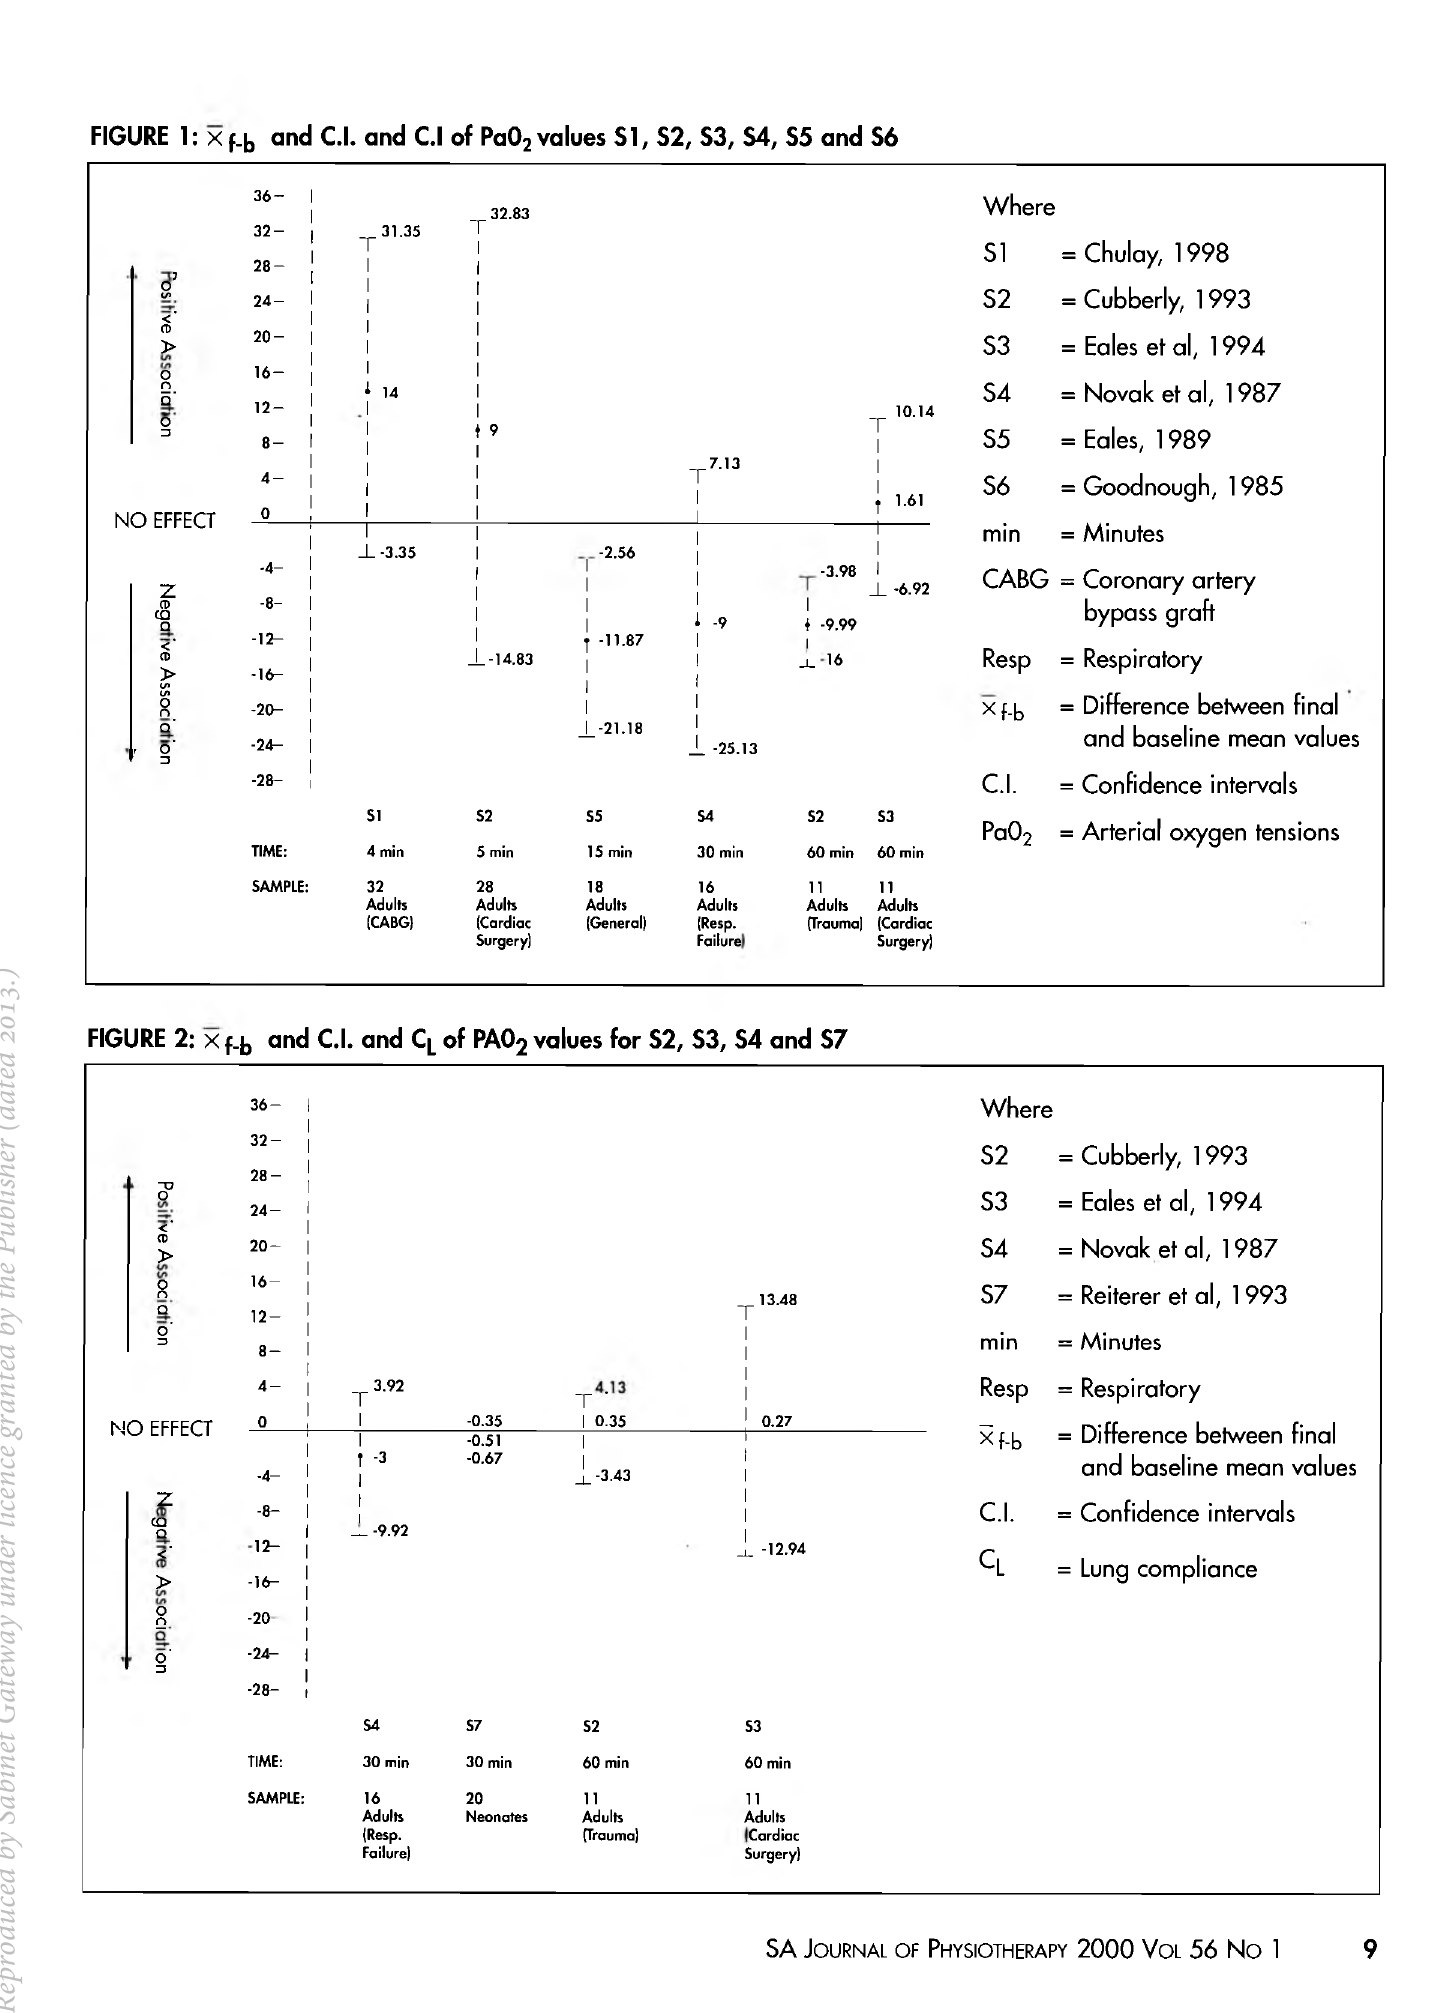
FIGURE 2: x f_ b and C.l. and C^ of PAO 2 values for S2, S3, S4 and S